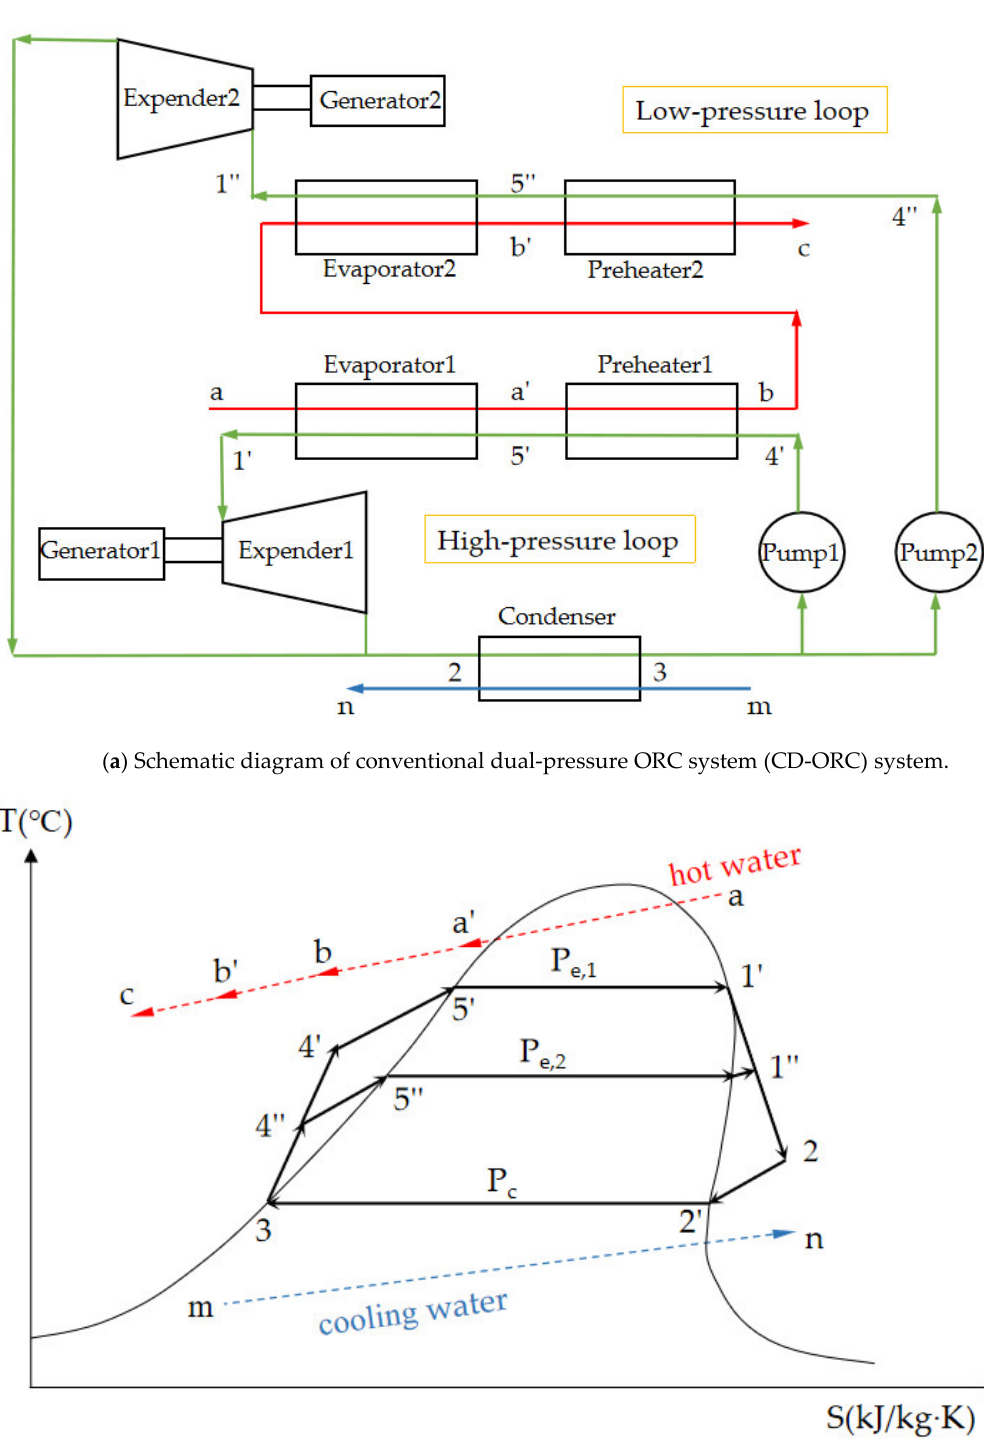
Figure 2. Scheme and the theoretical T - s diagram of CD-ORC system.